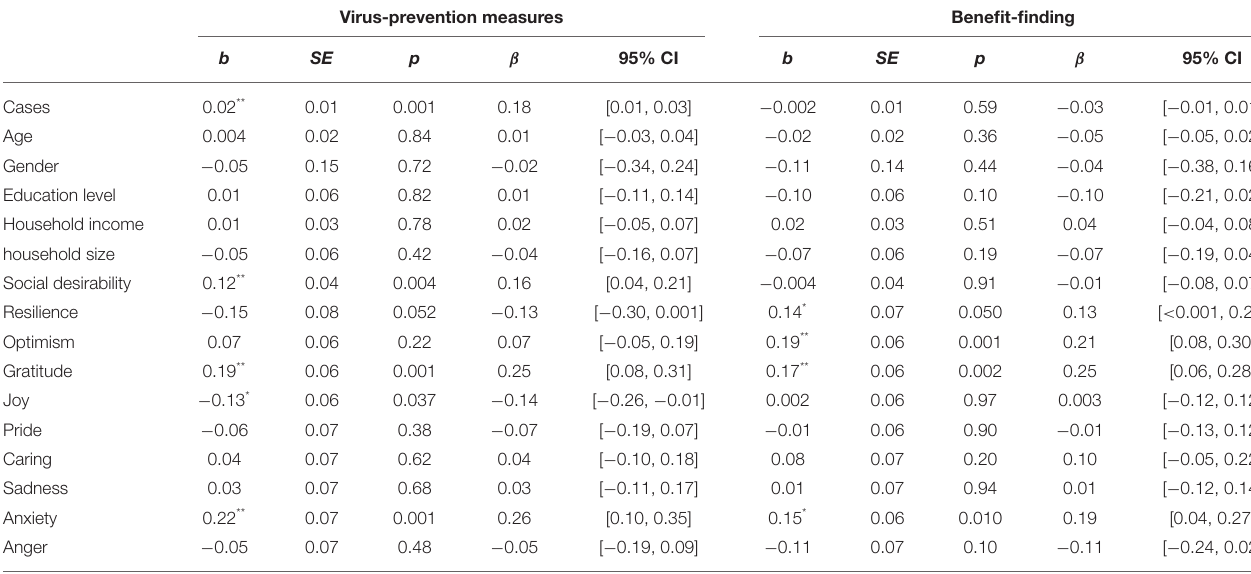
TABLE 3 | Regression coefficients predicting virus-prevention measures and benefit-finding. Virus-prevention measures Benefit-finding SE p